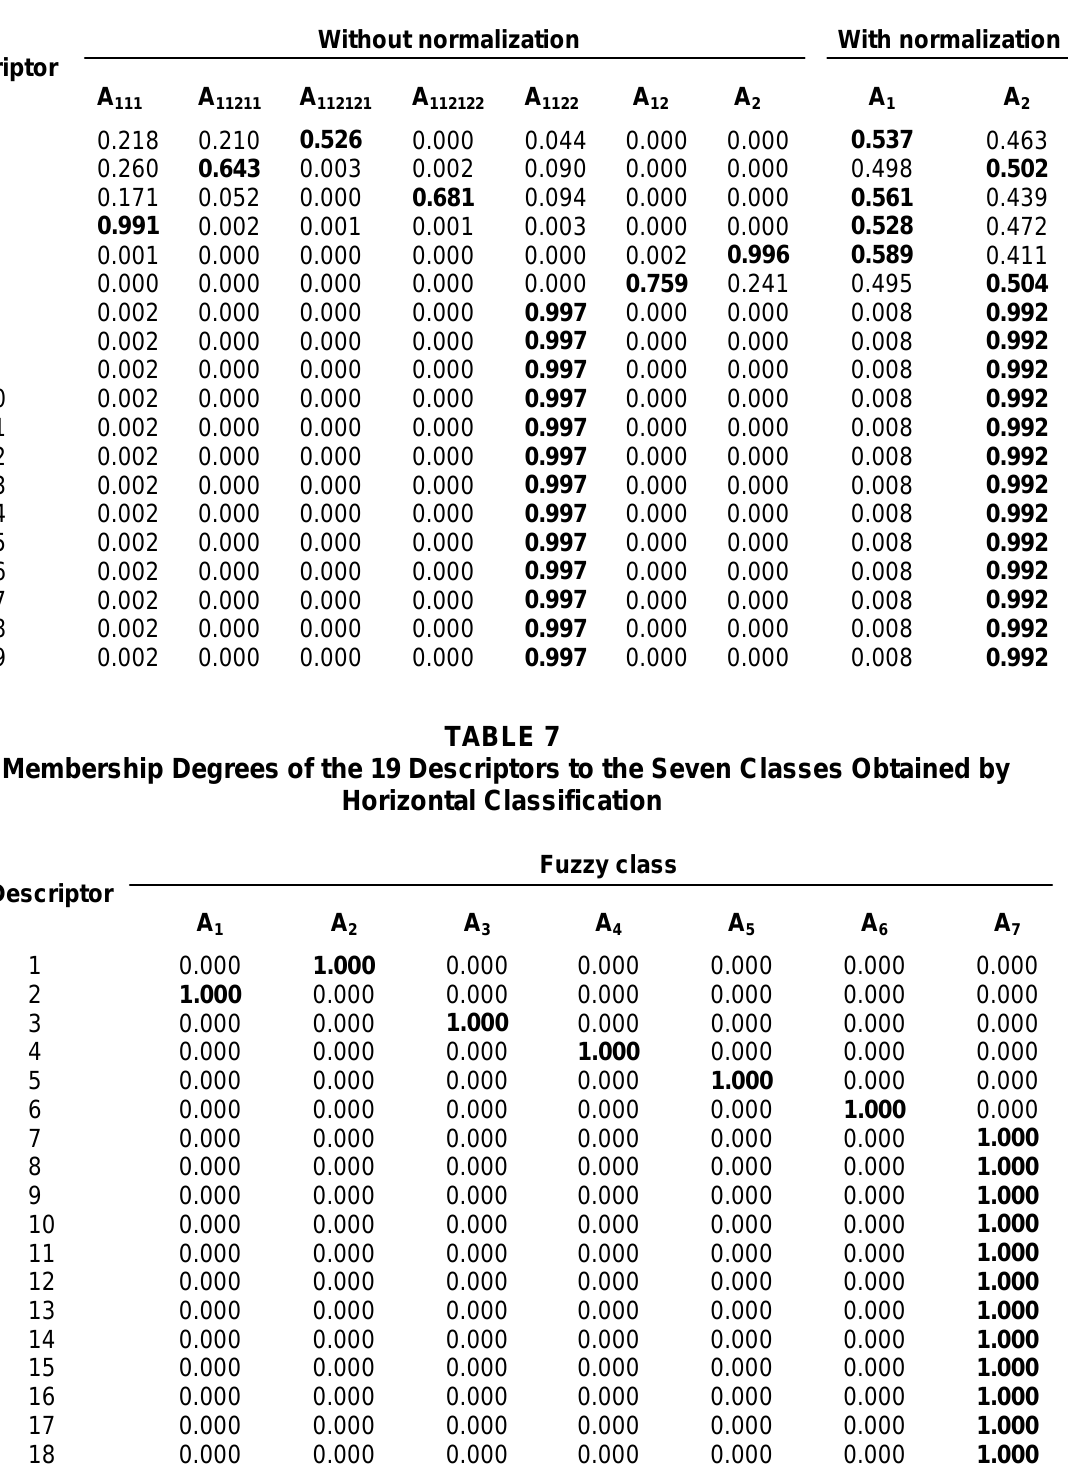
Membership Degrees of the 19 Descriptors to the Clusters of the Final